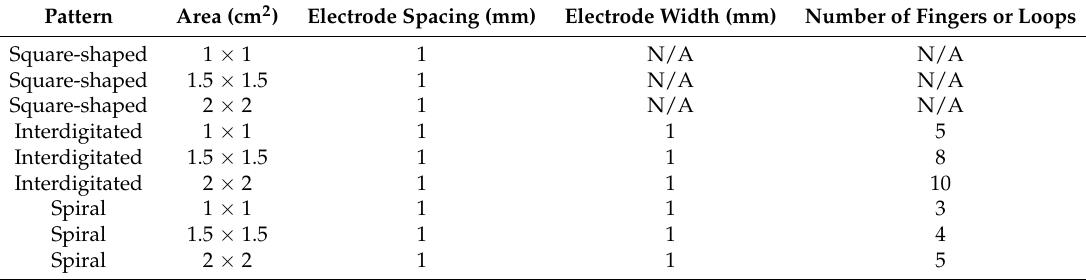
Figure 6. Change of the sensor’s capacitance with different patterns and different areas. Table 1. Parameters of FEF (fringing electric field) sensors in Figure